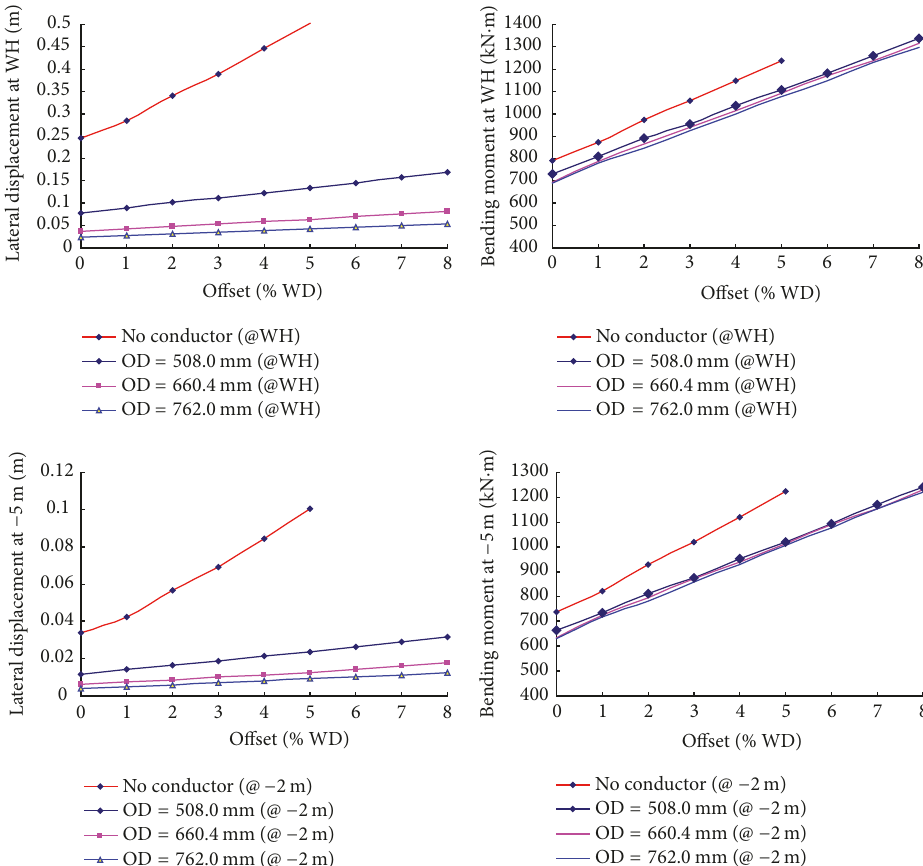
Figure 11: Effect of the platform offset and conductor size on wellhead and conductor.